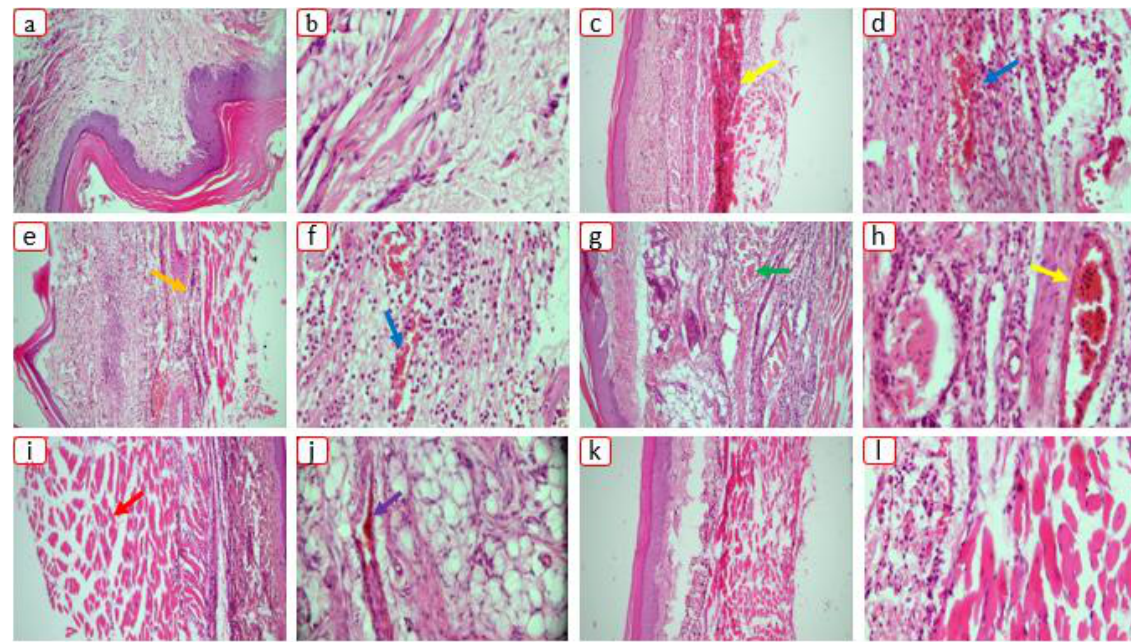
Figure 12. Histological appearance of the rat paw edema in ( a , b ) normal group, ( c , d ) diseased group, ( e , f ) Dex group, ( g , h ) S1group, ( i , j ) S18 group, and ( k , l ) S23 group. Here, the yellow arrow indicates cellular infiltration, blue arrow indicates inflammation, orange arrow indicates hyperplasia, green arrow indicates giant cells, red arrow indicates blood vessel, and purple arrow indicates bone ero- sion.